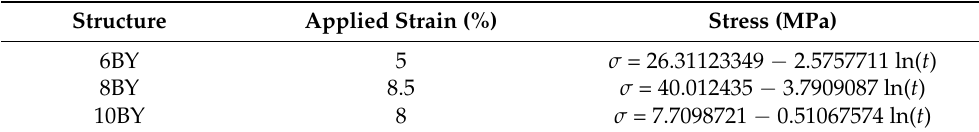
Table 4. Mean true stress within 2700 s for PVA braided architectures ( ε 0 = ε (0.16 σ u ). Structure